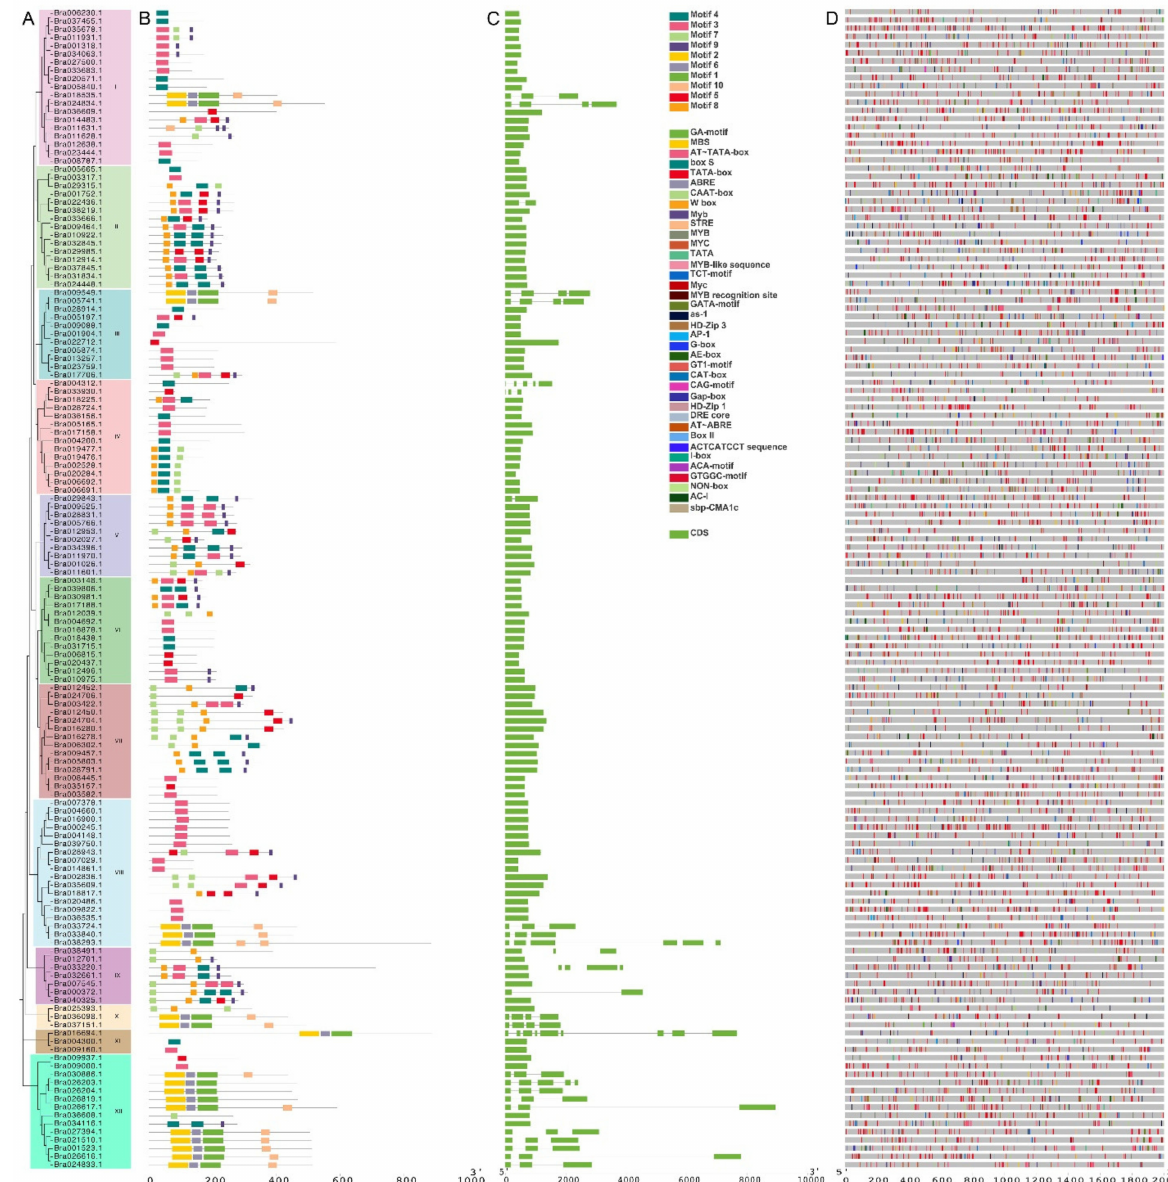
Figure 3. Analysis of the gene structure of the C2H2 ZFP gene family in B. rapa . ( A ) The 141 members are assigned to 12 sub-clusters. ( B ) Each colored box represents a motif, and the gray line represents a non-conserved sequence. ( C ) Exons and introns of each subgroup are indicated by green boxes and grey lines, respectively. ( D ) The specific colored boxes indicate the different cis -acting